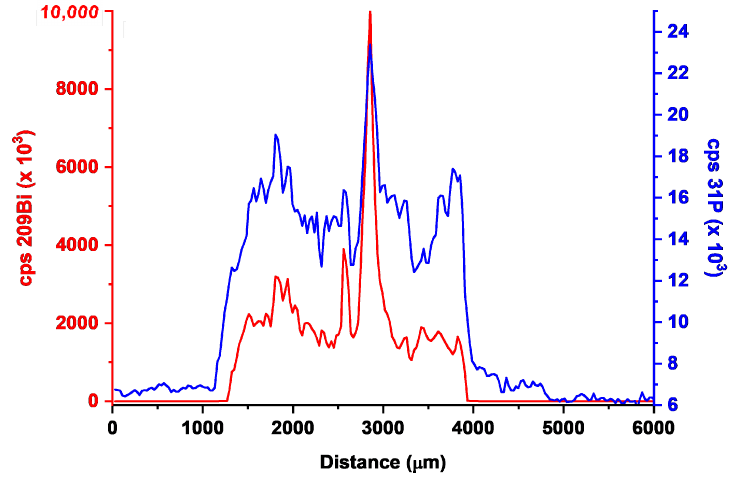
Figure 5. Comparison of the 209 Bi (red line) and 31P (blue line) laser ablation profiles located at 260 μ m on a freshly prepared, untreated Bi/PO 4 /PSS electrode. 260 µ m on a freshly prepared, untreated Bi / PO